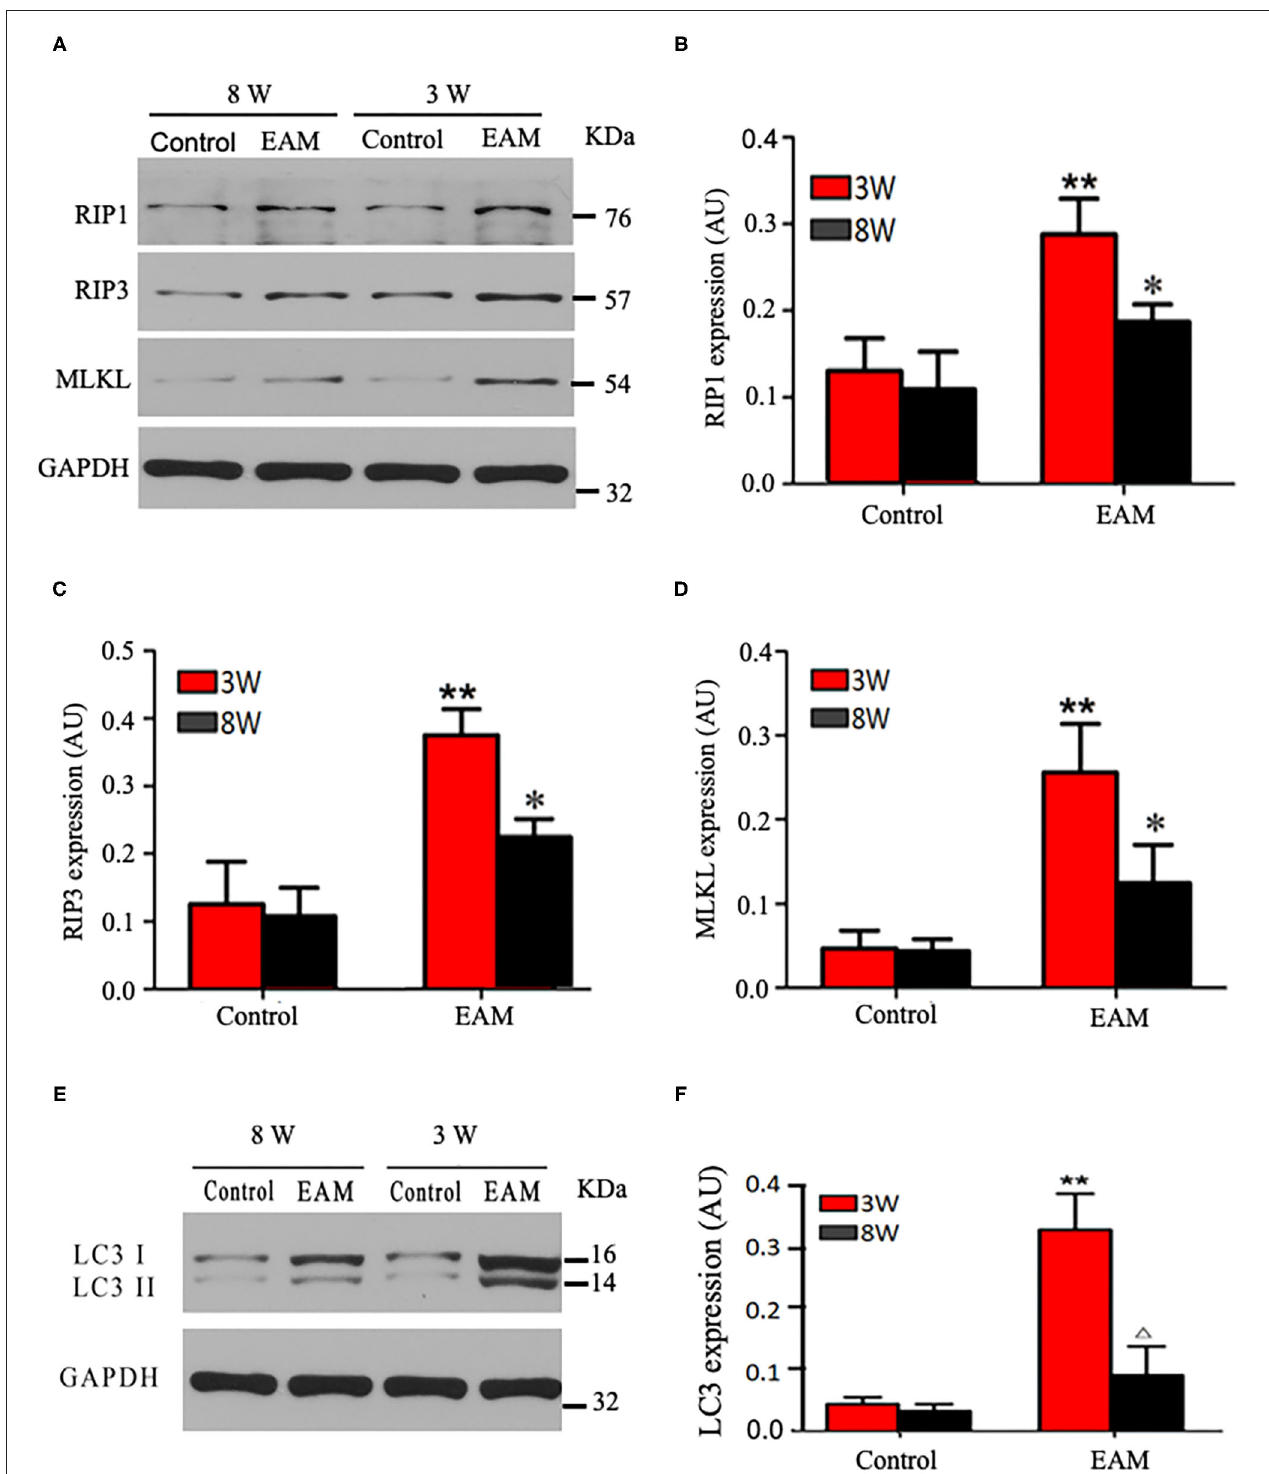
FIGURE 3 | Protein expression levels of RIP1, RIP3, and MLKL in myocardial tissues of acute and chronic stages detected by Western blot. (A) Western blot analysis of protein expression of RIP1/RIP3/MLKL in rat myocardium during “early” and “late” stages. (B–D) Quantification of RIP1 (B) , RIP3 (C) , MLKL (D) in (A) . (E) Western blot analysis of marker protein expression of autophagosome LC-3 I and LC-3 II in rat myocardium during “early” and “late” stages. (F) Quantification of LC-3 I and LC-3 II in e. All data are presented as mean ± SEM. A Student’s t -test was performed. ** p < 0.05 means compared with control group (3W); * p < 0.05 means vs. control Group (8 weeks)